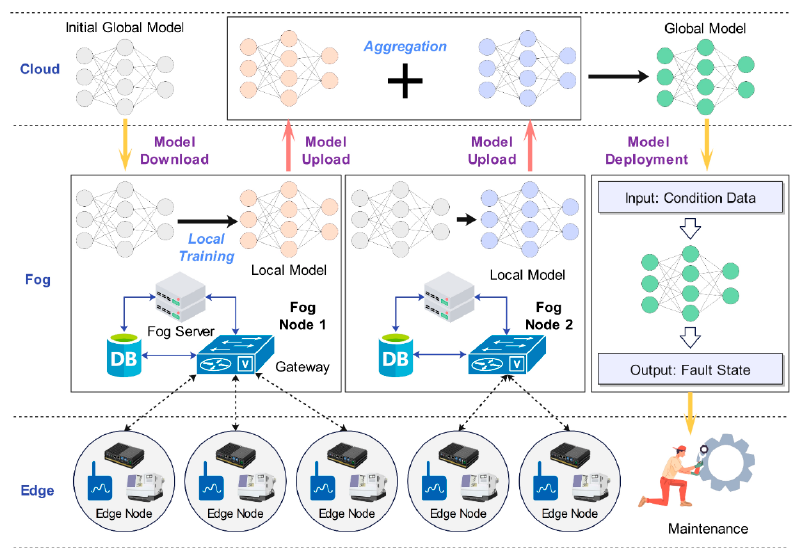
Figure 8. Fog computing framework fusing federated learning.